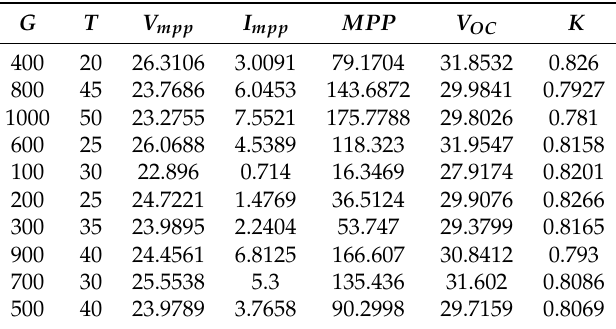
Figure 9. The approach used to produce the dataset for neural network training: ( a ) schematic diagram of the circuit ( b ) experimental setup. The electronic load used to sweep the voltage and get the I-V characteristic curve at specific irradiance and temperature values. Table 1. Sample of the recorded